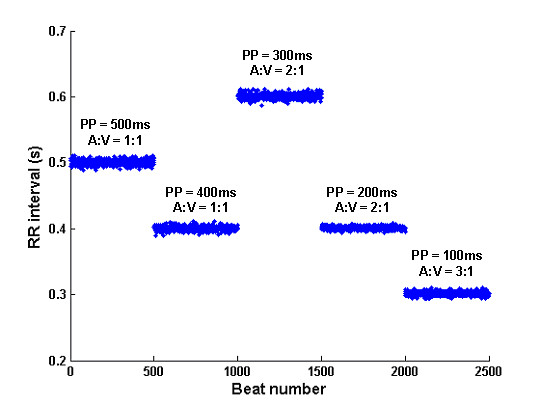
Example of simulated RR intervals in the presence of atrial flutter and AV block.